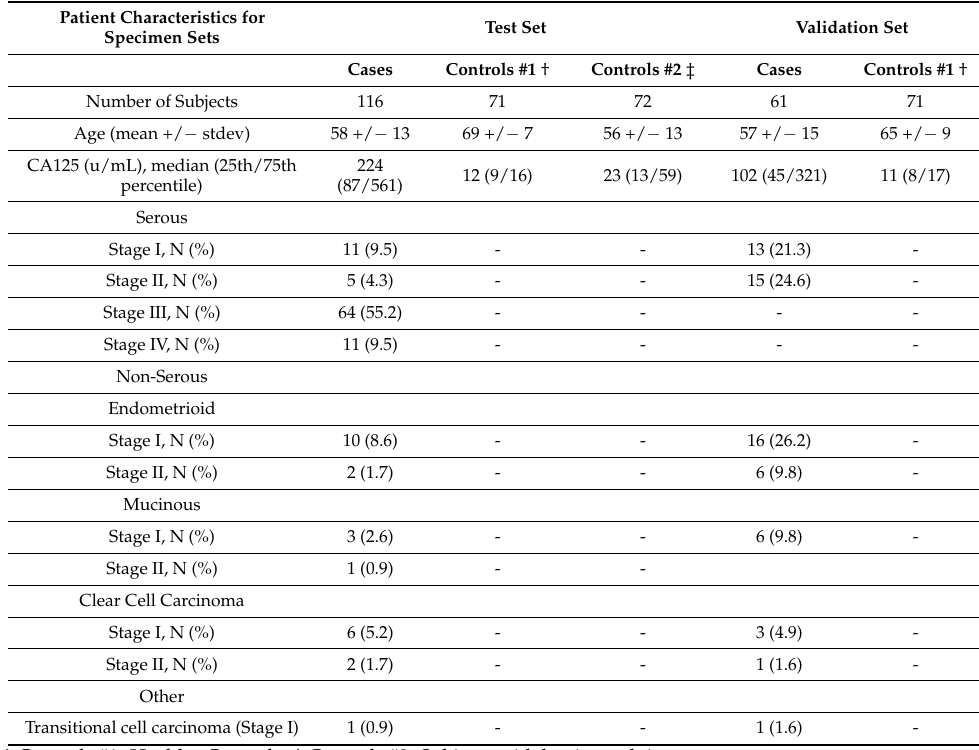
Table 1. Patient characteristics for the Test Set and Validation